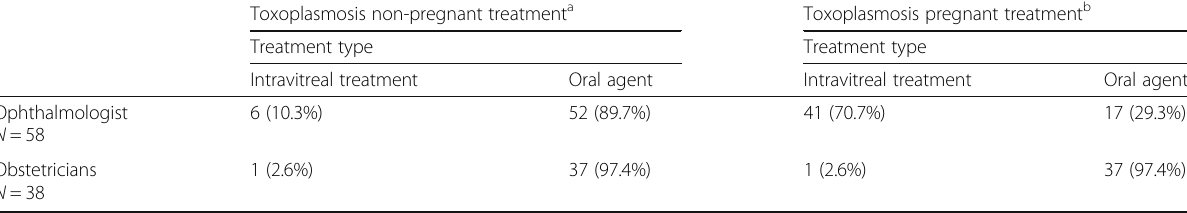
Table 2 Comparison of treatment choices of toxoplasmosis in non-pregnant and pregnant patients Toxoplasmosis non-pregnant treatment